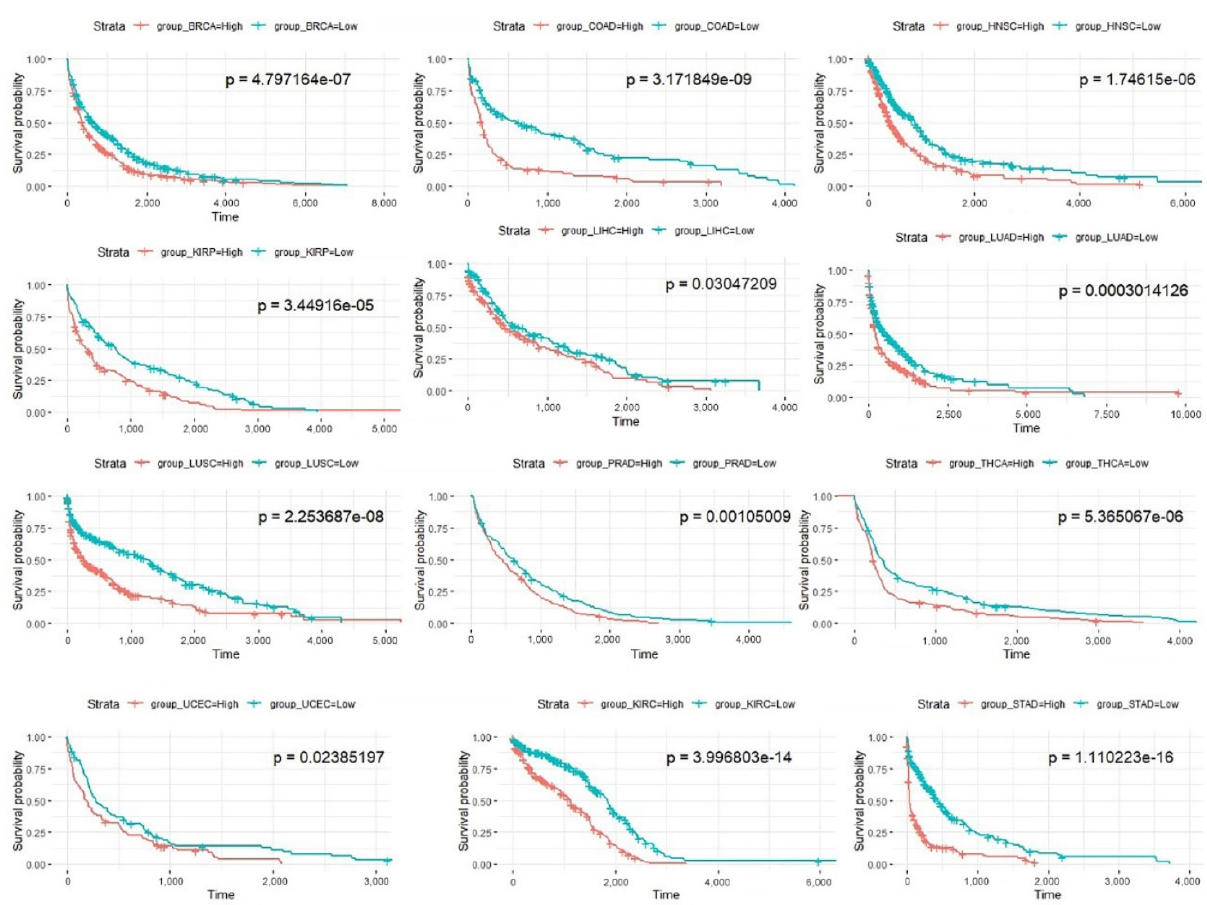
Figure 7. Kaplan-Meier curves of patients in the two risk groups dichotomized by deregulation of the prognosis pathways for 12 cancer types in TCGA. The x axis shows survival in days. The y axis shows the overall survival rate.